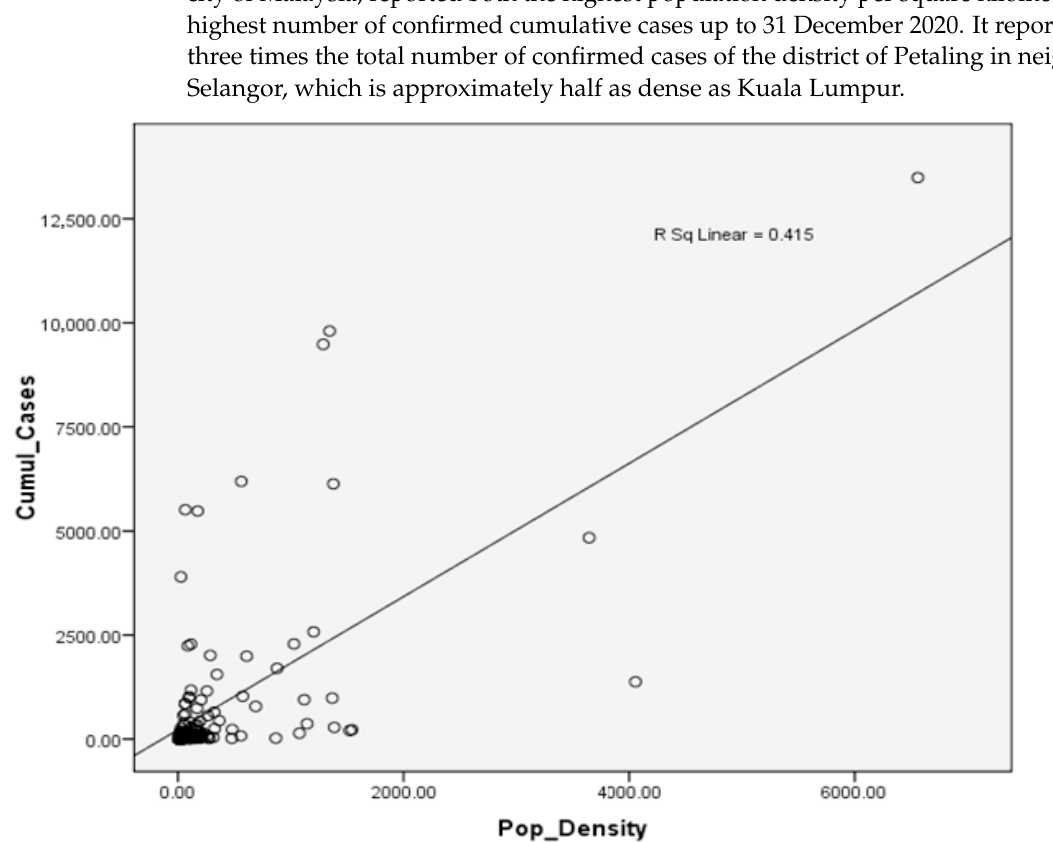
Figure 2. Analysis revealed a significant relationship between population density and cumulative COVID-19 cases in 2020. The model revealed an R-value of 0.644 and an R 2 value of 0.415.